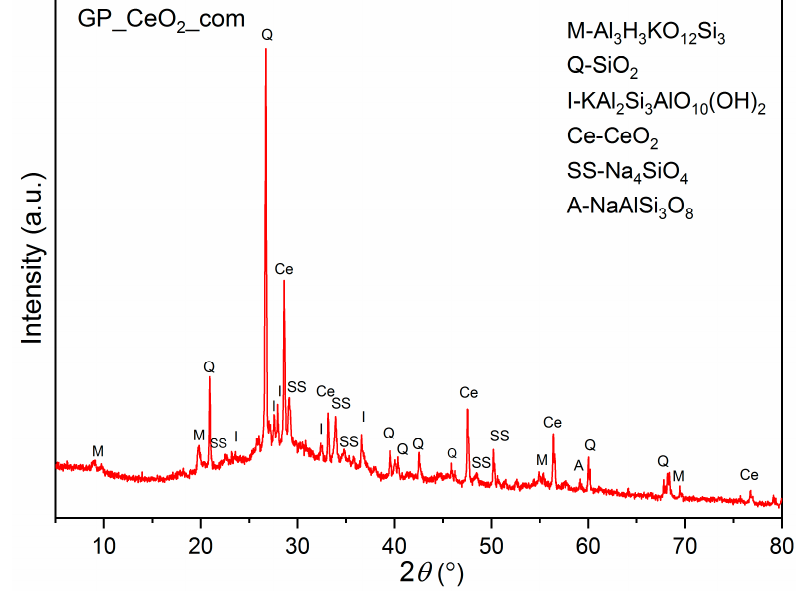
Figure 2. X-ray diffraction pattern of a GP_CeO 2 _com sample.